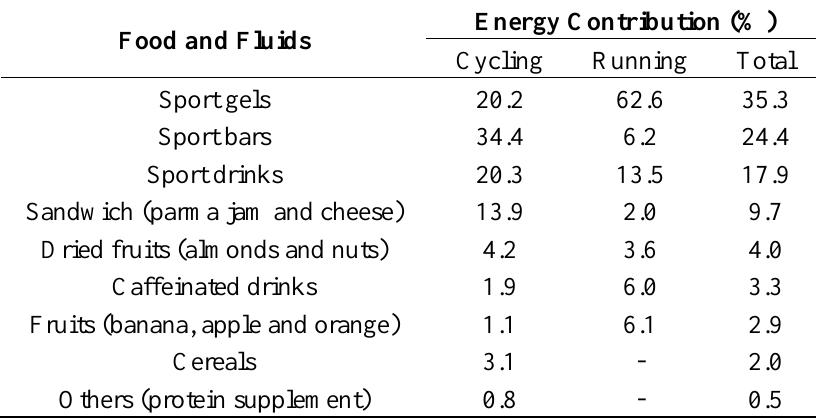
Table 2. Percentage of energy contribution from food and fluids during the ultra-endurance triathlon